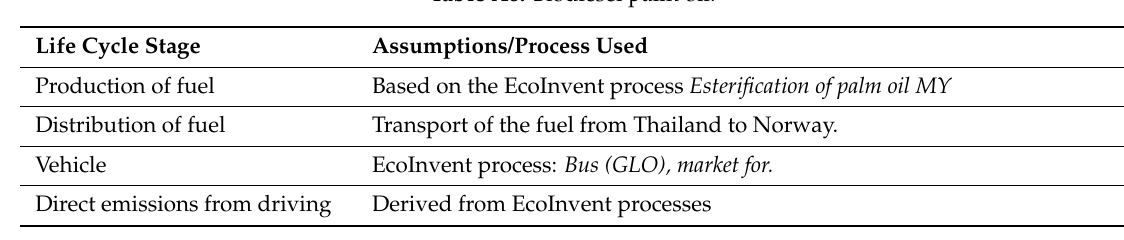
Table A8. Biodiesel palm oil.